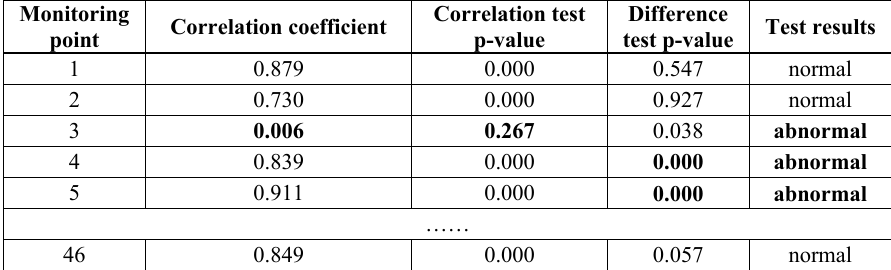
Table 1. Applicability test results of actual high-speed railway.